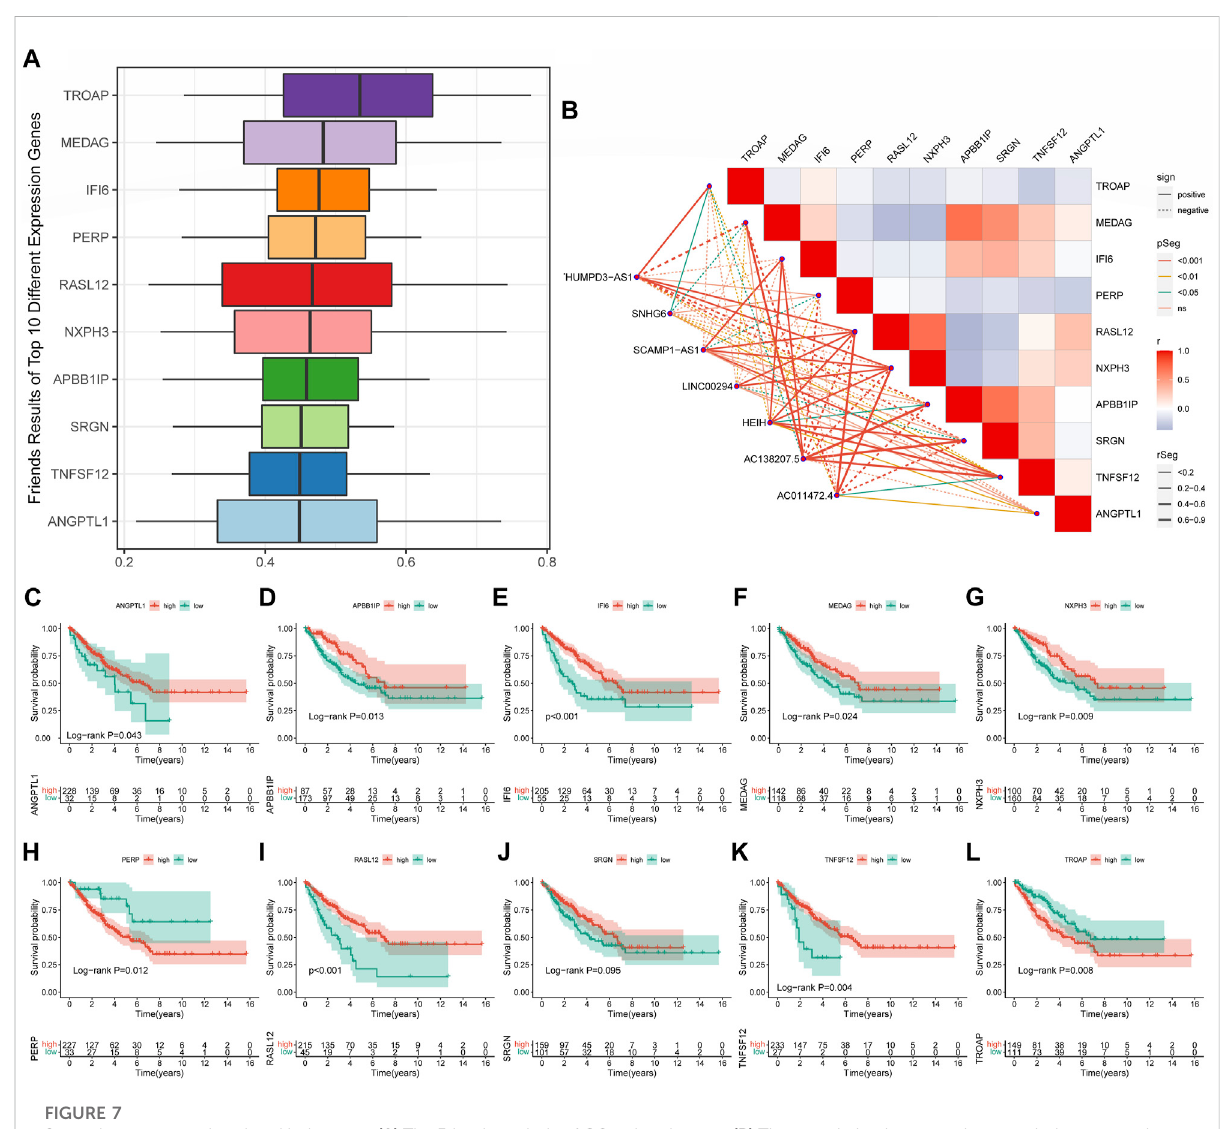
FIGURE 7 Screening cuproptosis-related hub genes. (A) The Friends analysis of GO-related genes. (B) The association between these ten hub genes and seven signature CRLs. (C – L) The K-M survival and ROC curve of these ten hub